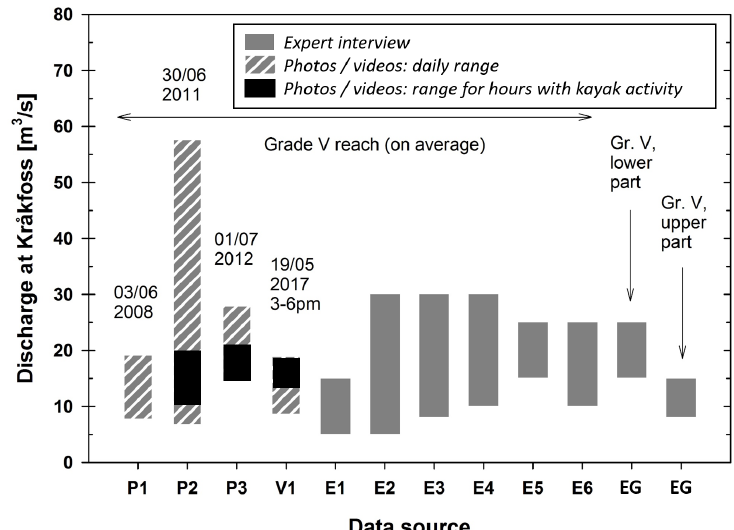
Figure 9. Overview of the estimated optimal flow ranges for the grade V reach of Teigdalselva River